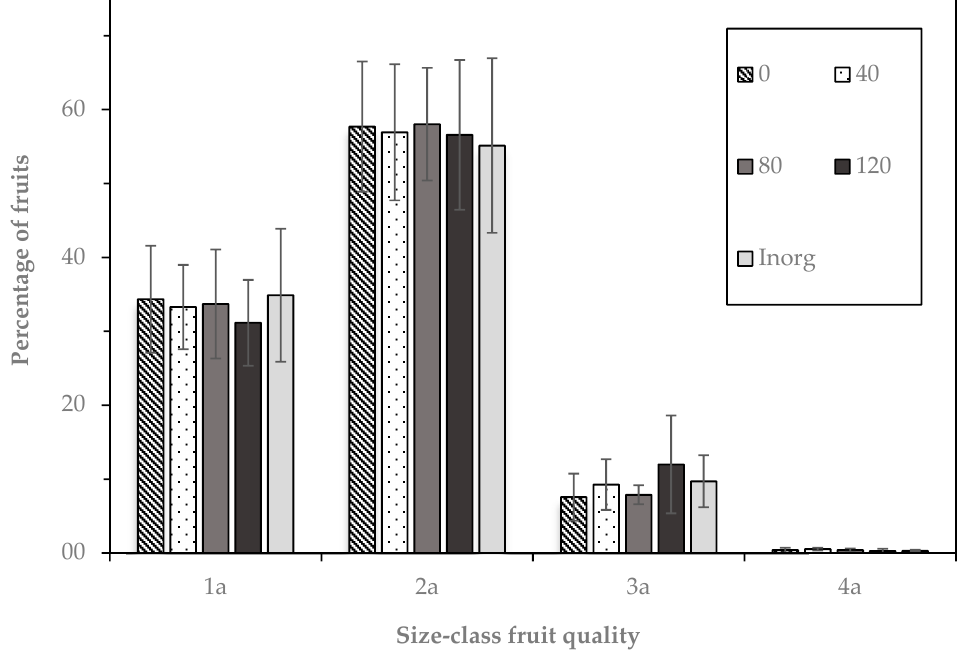
Figure 2. Sampling ( a ) and measurement ( b ) of fruits for the yield and size-quality classification.